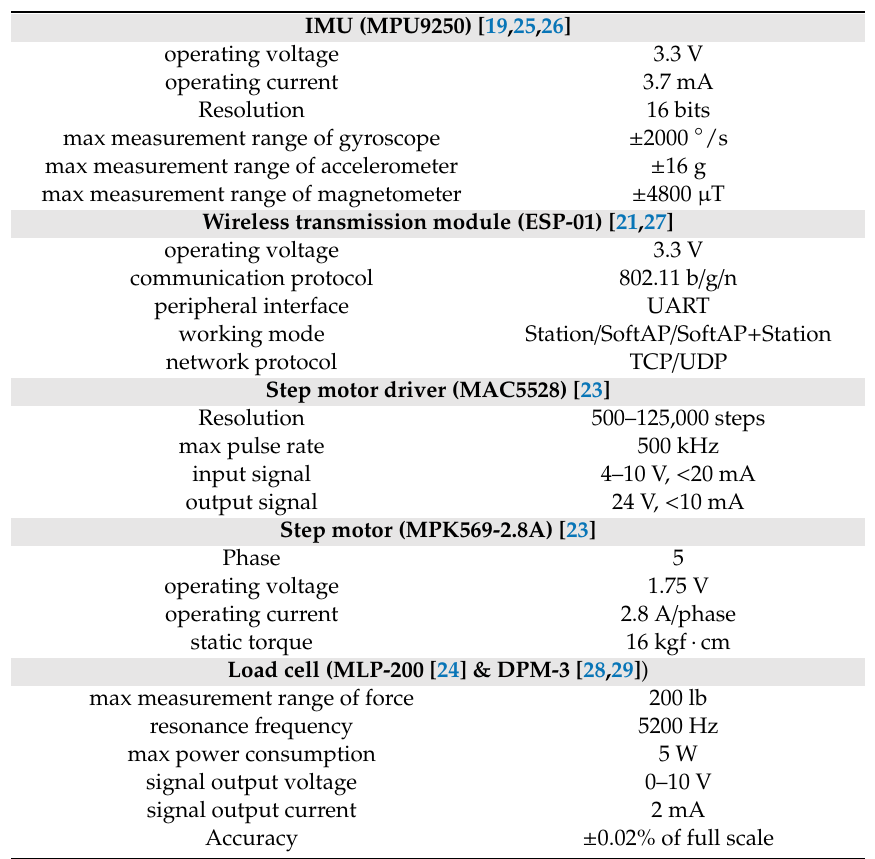
Figure 1. The automatic mobile trainer. ( a ) The physical structure; ( b ) the schematic diagram; ( c ) the system layout. Table 1. System specifications. IMU: inertial movement